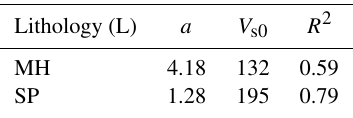
Table 1. Coefficients ( a = slope, V s0 = intercept) of the regression model for two lithologies (L) and related coefficient of determina- tion ( R 2